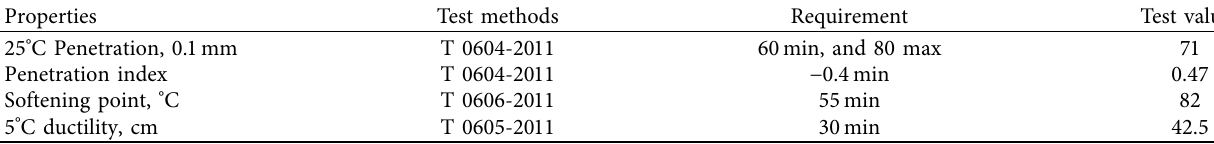
Table 1: Properties of the SBS-modified asphalt.